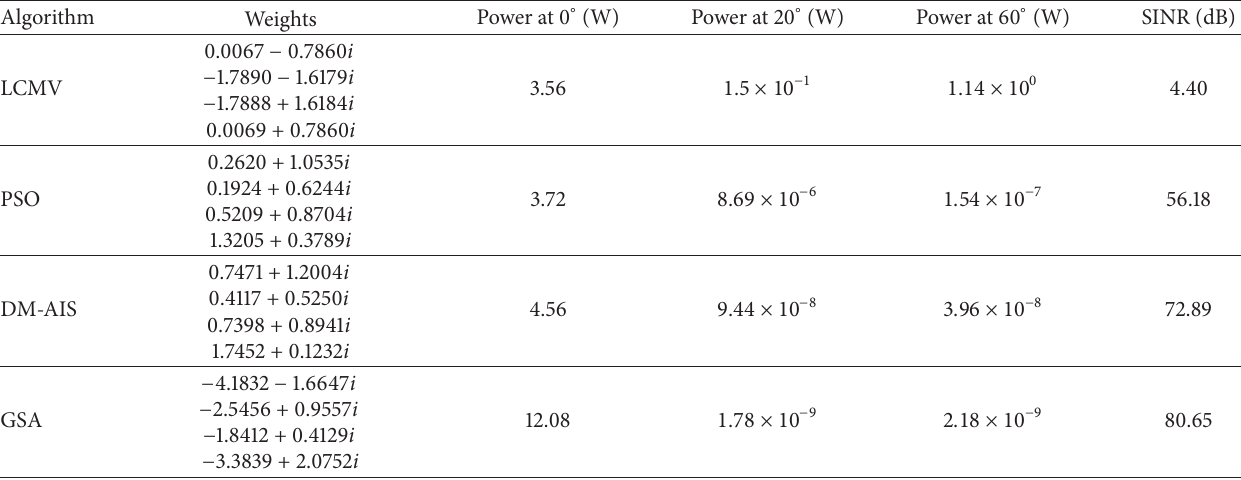
Table 3: Comparison of weight vectors, power values, and SINR calculation for conventional LCMV, PSO-LCMV, DM-AIS-LCMV, and